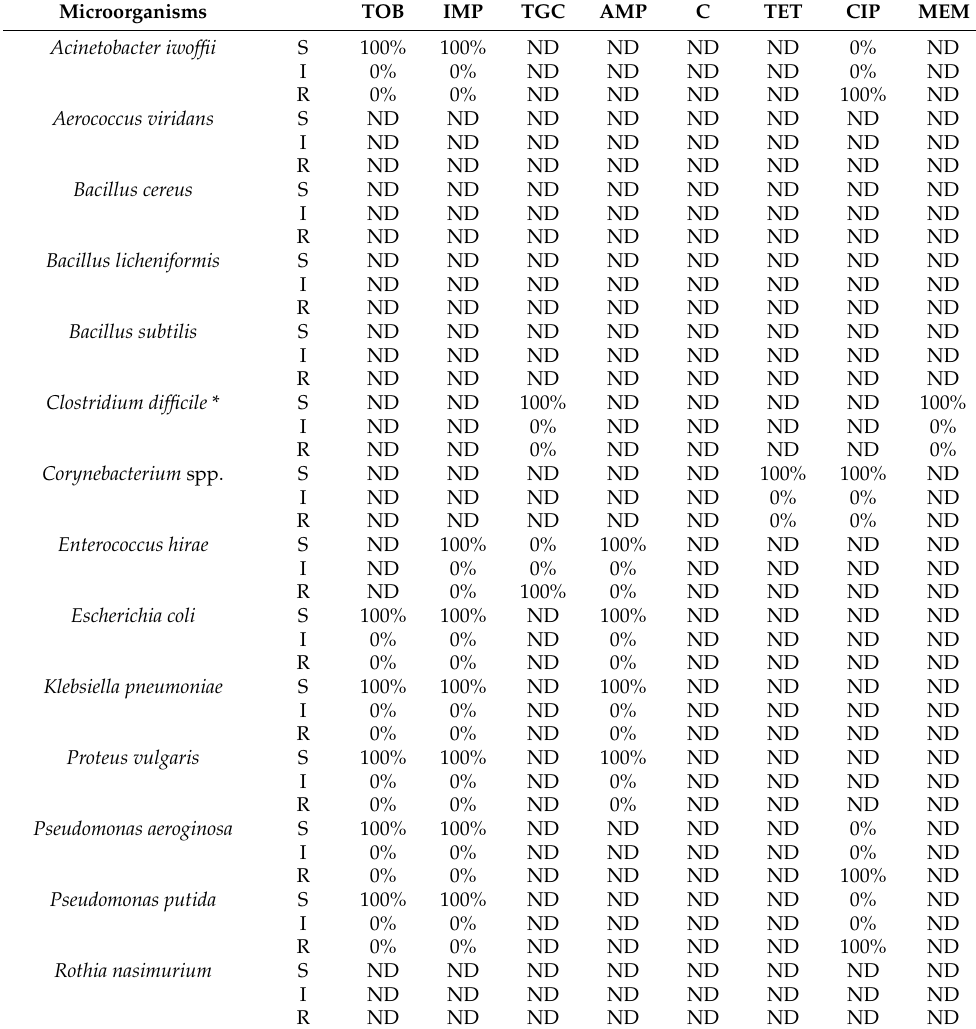
Table 10. Resistance profiles of bacteria recovered from extended boar semen. Microorganisms